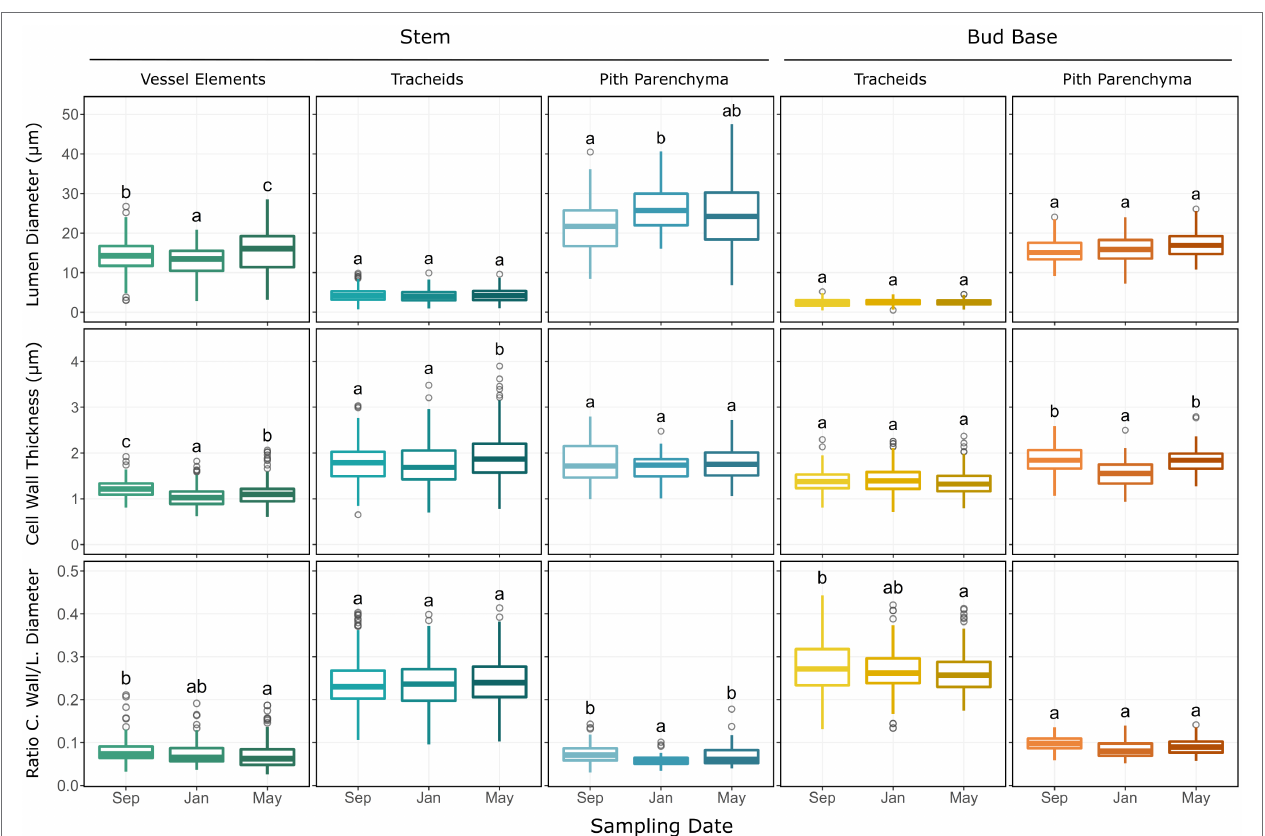
FIGURE 4 | blue and basic fuchsin; dark blue indicates primary cell wall and pink/magenta secondary cell wall with high cellulose content. (A) Transverse section in the bud base and (B) in the stem zone both indicating xylem and pith area. (C–E) Transverse sections of vascular tissues in the bud base for (C) September, (D) January, and (E) May. (F–H) Transverse sections of pith tissue in the bud base for (F) September, (G) January, and (H) May. (I–K) Transverse sections of pith tissue in the stem for (I) September, (J) January, and (K) May. (L–N) Longitudinal sections of the bud base showing tracheids for (L) September, (M) January, and (N) May. X: Xylem, P: Pith. Scale bars (A,B) = 0.5 mm, (C–N) = 25 μm.